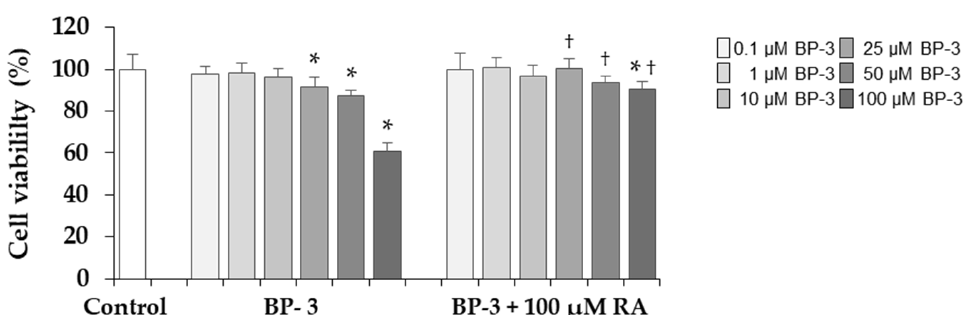
Figure 2. The influence of benzophenone-3 (BP-3) alone and in combination with rosmarinic acid (RA) on the viability of fibroblasts. Values represent the mean ± SD of three experiments done in duplicate; * p < 0.05 vs. control (untreated cells); † p < 0.05 vs. respective samples treated with BP-3 alone. The data are expressed as a percentage of the control sample assumed as 100%.